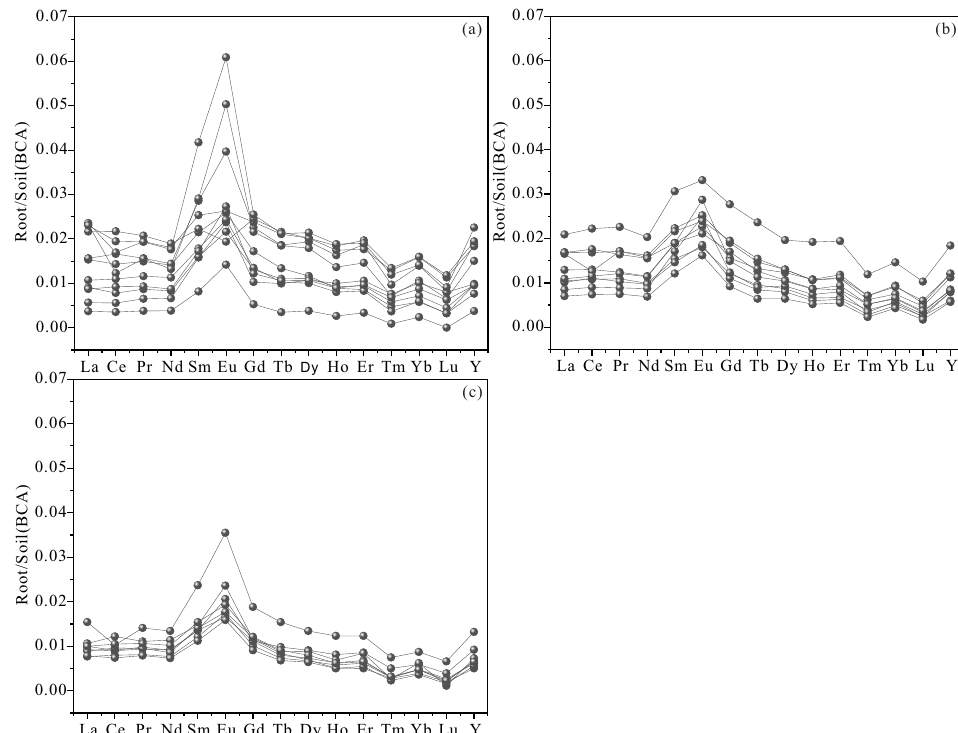
Figure 9. BACs distribution patterns of REEs in roots of Scutellaria baicalensis . ( a ) NGHs; ( b ) APHs; ( c )